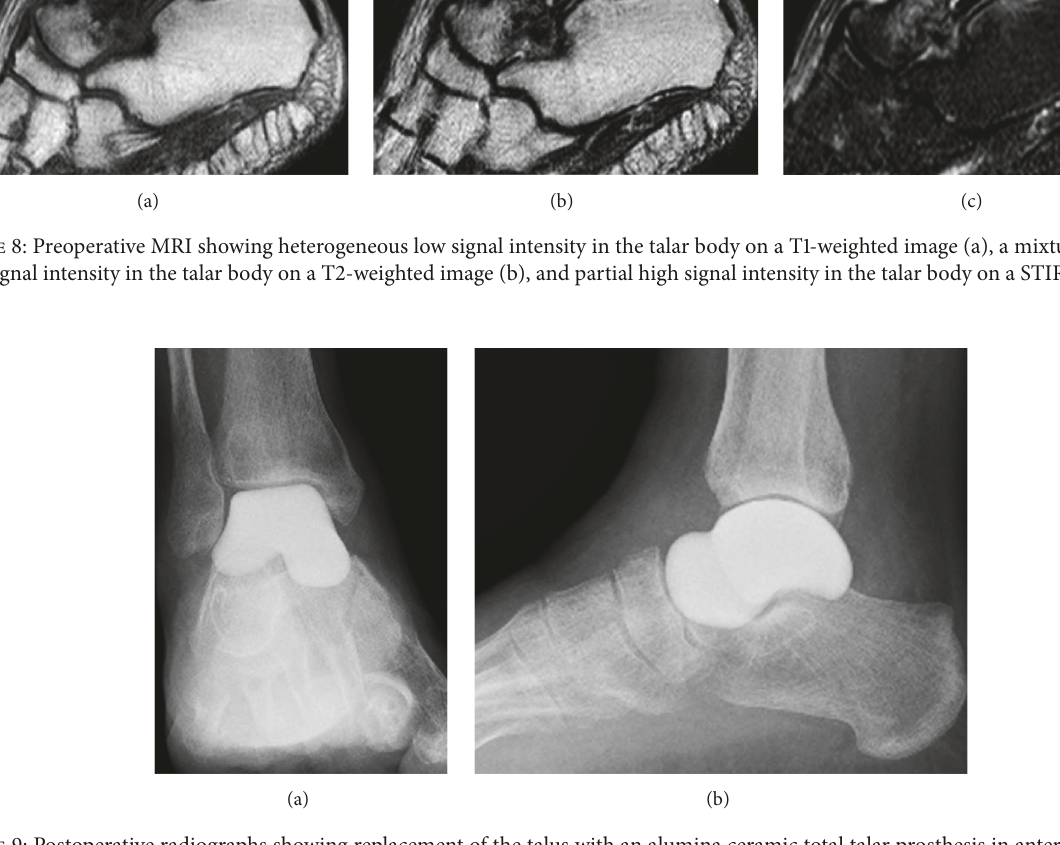
Figure 9: Postoperative radiographs showing replacement of the talus with an alumina ceramic total talar prosthesis in anteroposterior (a) and lateral (b) views at 1 year and 6 months after surgery. There is excellent congruence between the talar prosthesis and the tibia, fibula, calcaneus, and navicular